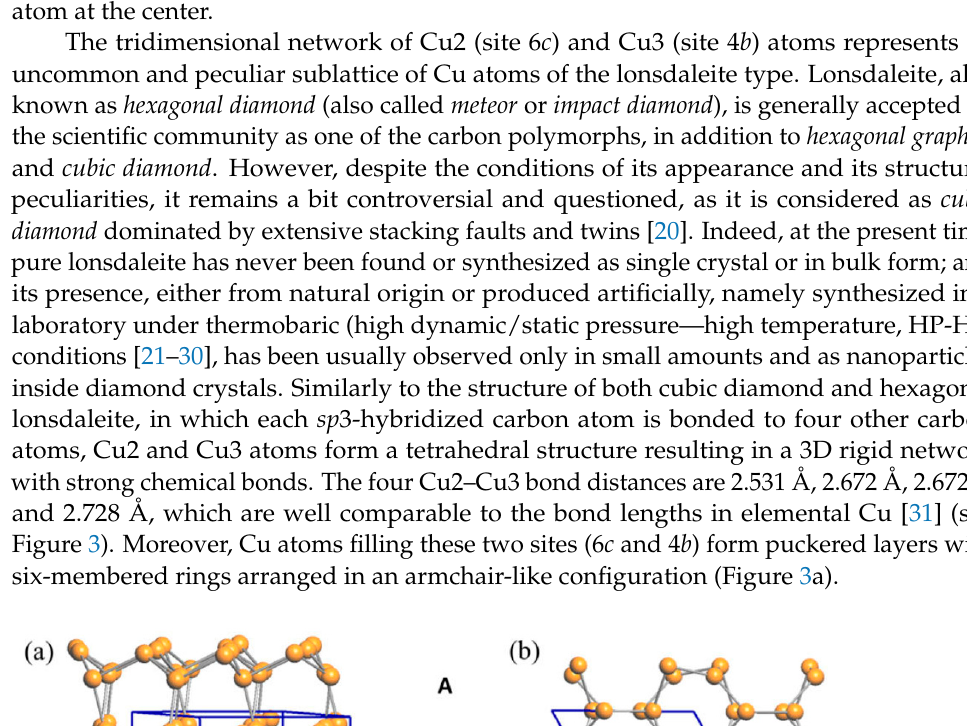
Figure 4. ( a ) Triangular ‘Cu 3 As’ unit (Cu4 − Cu1 − Cu4) hosting one As atom (6 c ) and placed inside one three-rings cage of the first tridimensional Cu sublattice. One of the tetrahedral units [Cu@Cu 4 ]